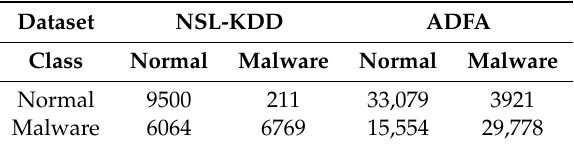
Table 11. Performance of the One-Class Support Vector Machine.